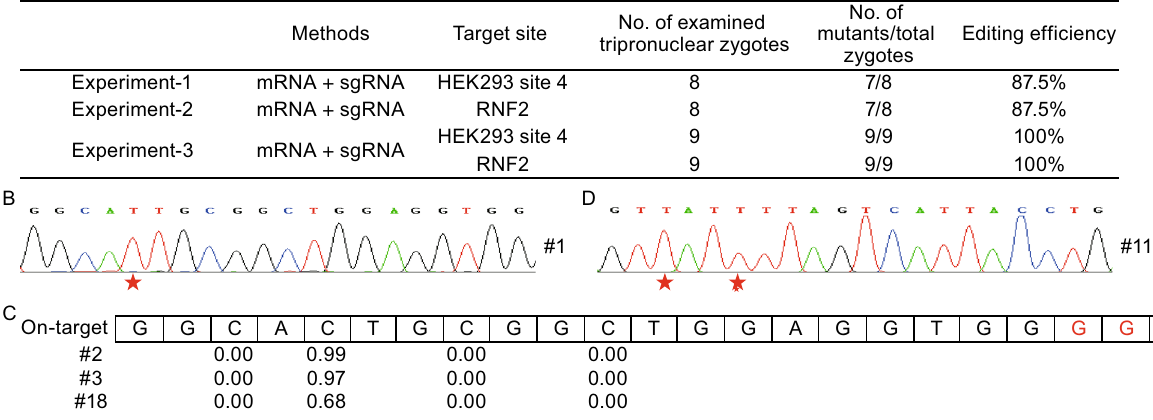
Figure 1. Highly ef fi cient base editing by BE3 in discarded human tripronuclear embryos . (A) Summary of the information of the experiments. (B) The representative sequence chromatogram of site4 from sample #1. The sequence was the targeted sites. The red star indicated the conversion of C to T. (C) Summary of the deep sequencing of the on-target site for HEK293 site4. The editing ef fi ciency of every C within the target site was indicated. The PAM was highlighted in red. (D) The representative sequence chromatogram of RNF2 from sample #11. The sequence was the targeted sites. The red star indicated the conversion of C